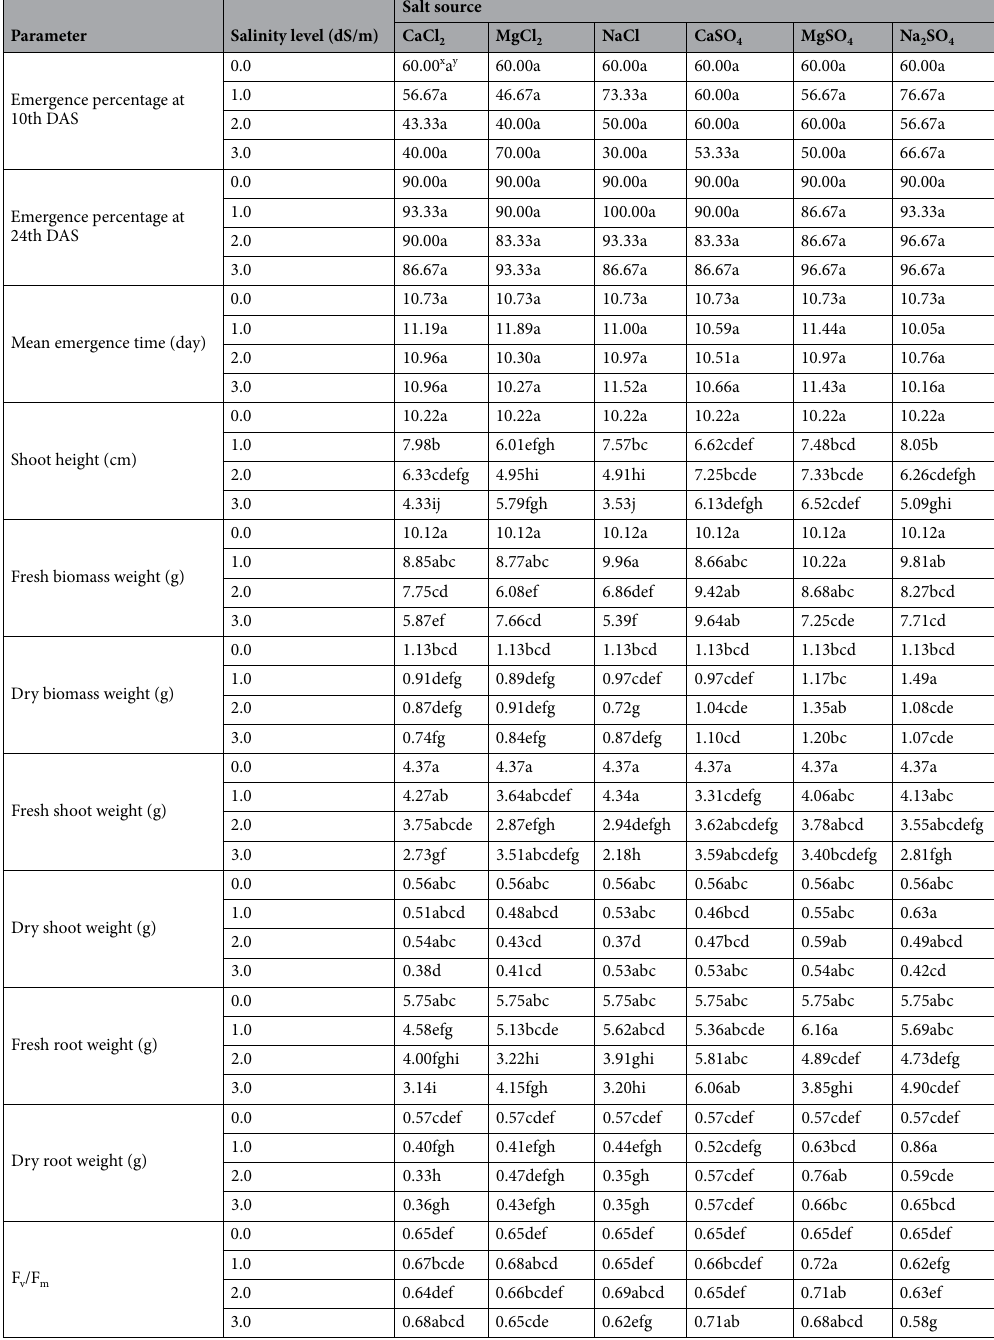
Table 7. The interaction effects of S × L on USK-1 faba bean genotype. x Each value is the mean of three replications. y Within salt source and salinity level of each parameter, means followed by the same letter are not significantly different at the 5% level according to Duncan’s multiple range